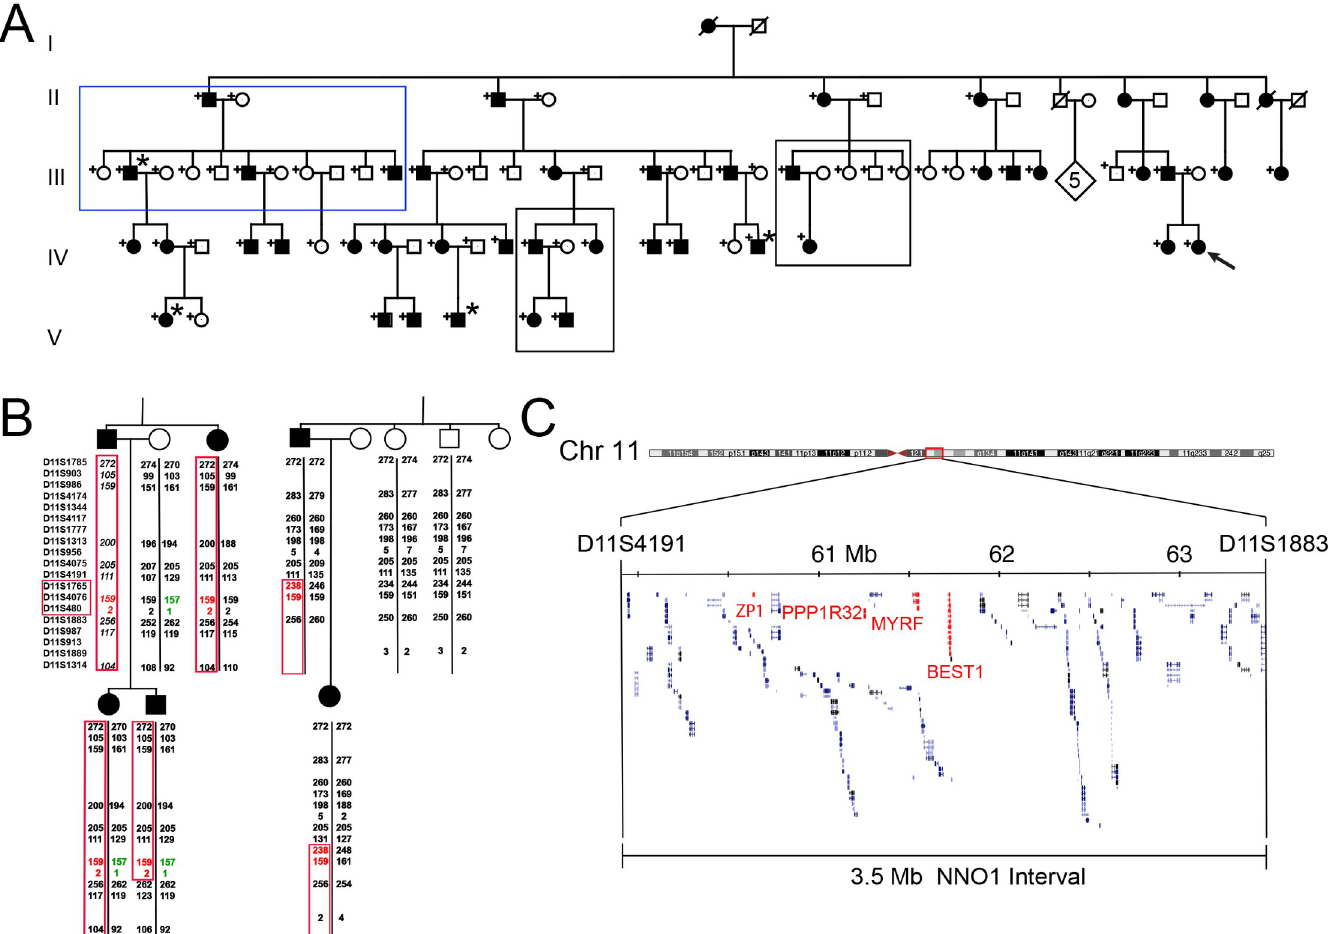
Fig 2. Haplotype analysis and fine mapping of NNO1 interval. (A) Updated NNO1 pedigree highlighting 4 individuals with dextrocardia ( � ) from different branches of the family. Blue box denotes subset of family that was subsequently chosen for segregation analysis. Black boxes indicate key regions of the pedigree with recombination events. (B) Haplotype analysis of key recombinants in the NNO1 pedigree showing minimal recombinant interval between D11S4191 and D11S1883 (highlighted in red). Disease haplotype is outlined with red boxes, and one example of shared non-disease haplotype is highlighted in green. Italics denote a deduced haplotype. (C) Genomic region encompassed by the non-recombinant interval on chromosome 11q ( MYRF , ZP1 , PPP1R32 , and BEST1 location with the interval are highlighted in red).